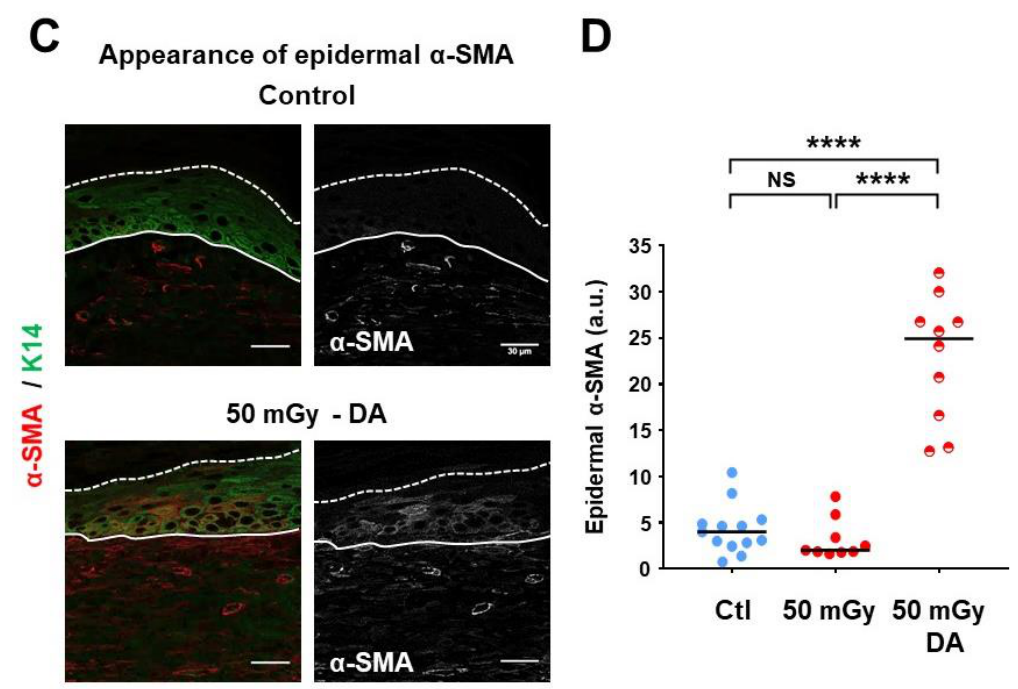
Figure5. Detectionofepithelial-to-mesenchymaltransitionmarkersindysplasticareas. ( A )Immunofluorescence detection of ZEB1. Representative pictures were selected for the visualization of dermal ZEB1 expression in normal skin regions and its ectopic presence in epidermal DAs. Gray-tone visualization of ZEB1 signal is also shown. ( B ) Quantitative analysis showed rare ZEB1-positive keratinocytes in normal epidermis regions, and abundant ZEB1-positive keratinocytes in DAs. Dot plots cumulated the analyses of 26 normal regions from the 14 control (Ctl) xenografts, 25 random regions from the 14 xenografts of the 50 mGy condition and 10 selected regions corresponding to DAs in 50 mGy xenografts. Bars correspond to median values (NS p > 0.05; **** p < 0.0001). β -catenin staining, which marked keratinocyte contours, revealed impaired epidermal organization and its reduced expression. ( C ) Immunofluorescence detection of α -smooth muscle actin ( α -SMA). Representative pictures were selected for the visualization of dermal α -SMA expression in normal skin regions and its abnormal presence in epidermal DAs. Sections were stained for keratin 14 to mark basal keratinocytes. Gray-tone visualization of α -SMA signal is also shown. ( D ) Dot plots cumulated the analyses of 13 normal regions from control (Ctl) xenografts, 9 random regions from the 50 mGy xenografts and 10 selected regions corresponding to DAs in 50 mGy xenografts. Bars correspond to median values (NS p > 0.05; **** p <